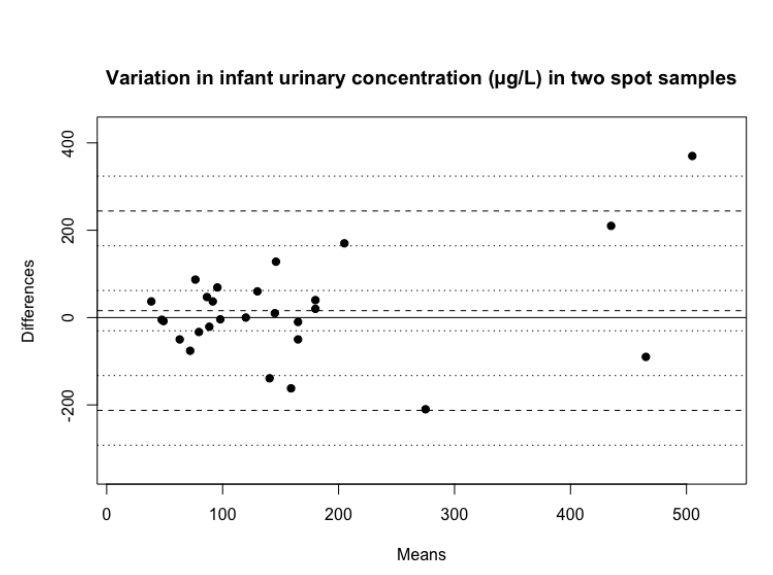
Figure 2. Variation in iodine concentration between the two spot samples of infant urine, including observed average agreement and 95% confidence intervals. y = 0 is the line of perfect average agreement.